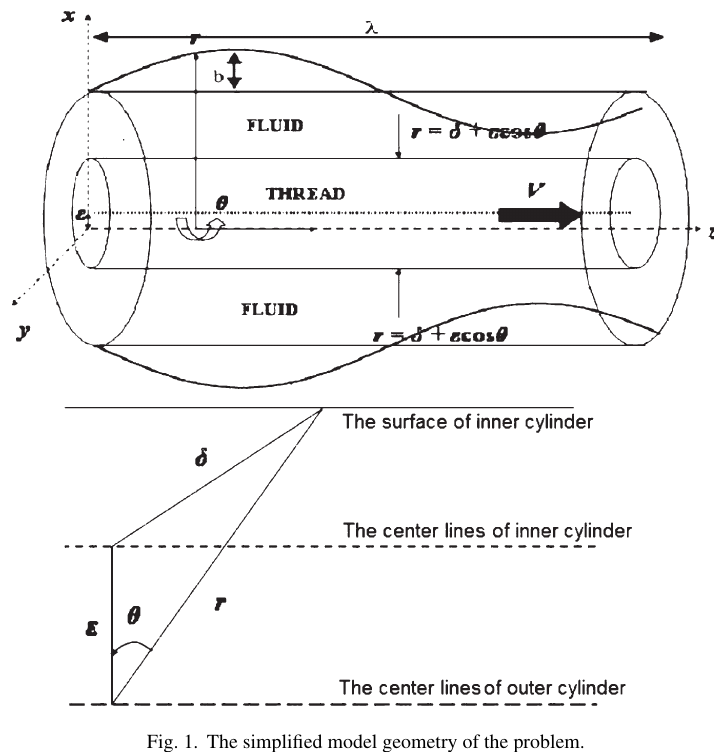
Fig. 1. The simplified model geometry of the